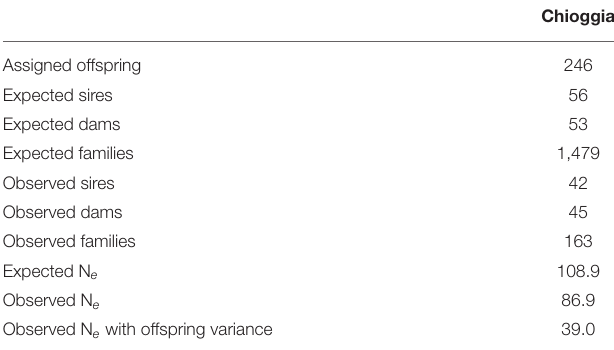
TABLE 3 | Full summary of traits recorded in Chioggia F1 group.